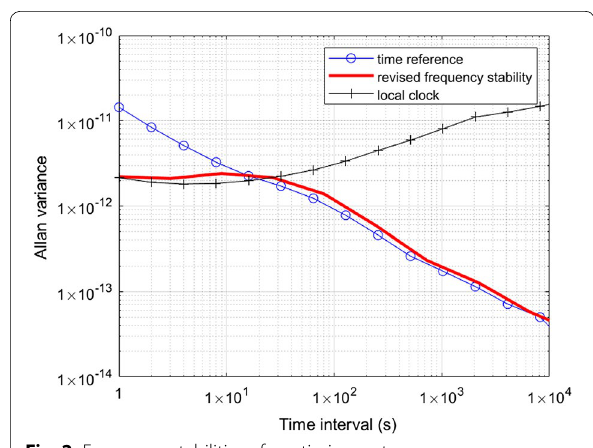
Fig. 2 Frequency stabilities of our timing